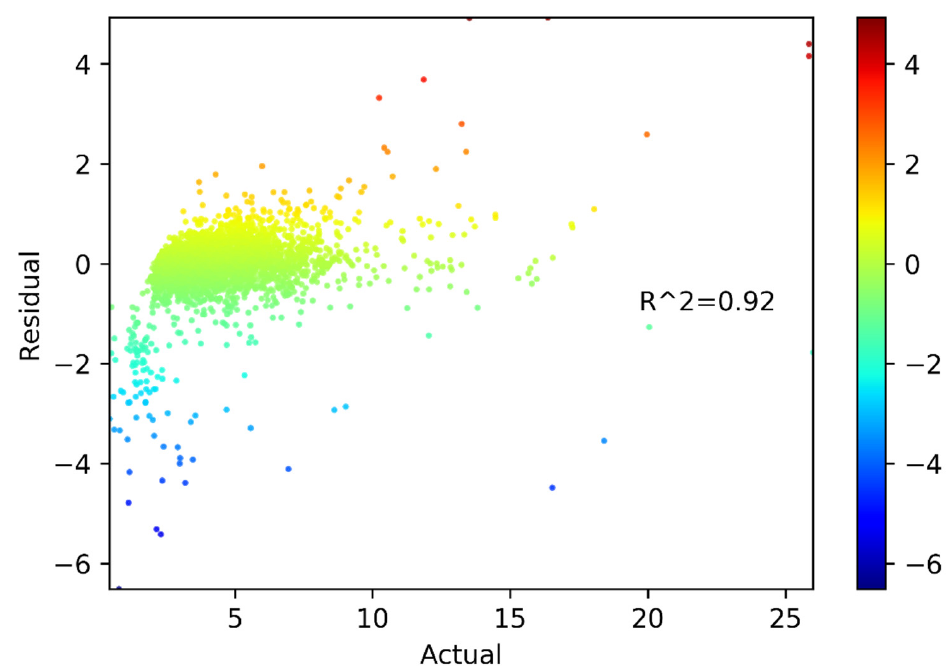
Figure 6. Property prices and residuals based on test set (RF).